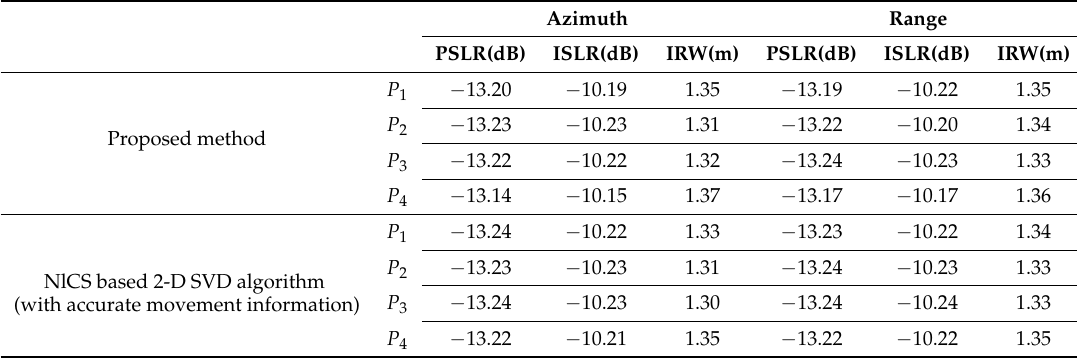
Table 2. Imaging quality evaluation.